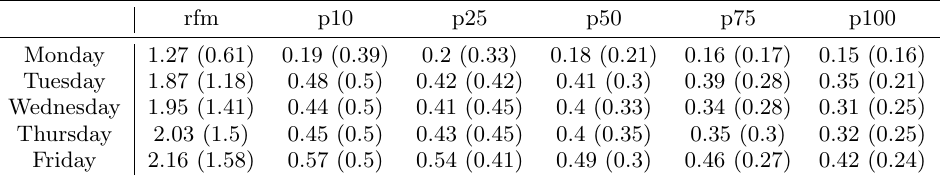
Table 9: Per day of the week metrics for Taxis in Rome, setup with the highest improvement